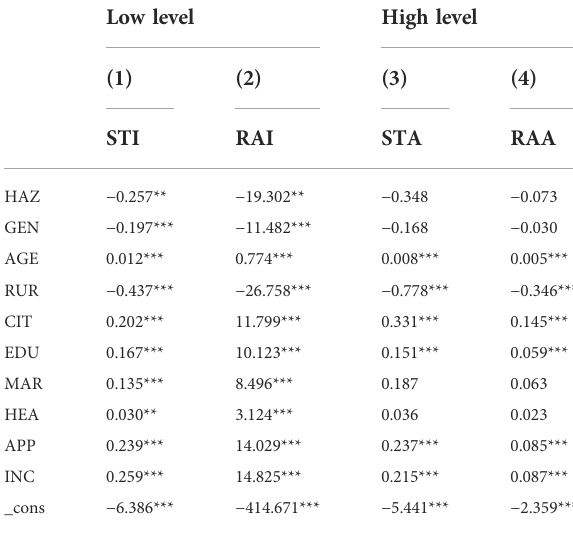
TABLE 3 Heterogeneity analysis of fi nancial literacy